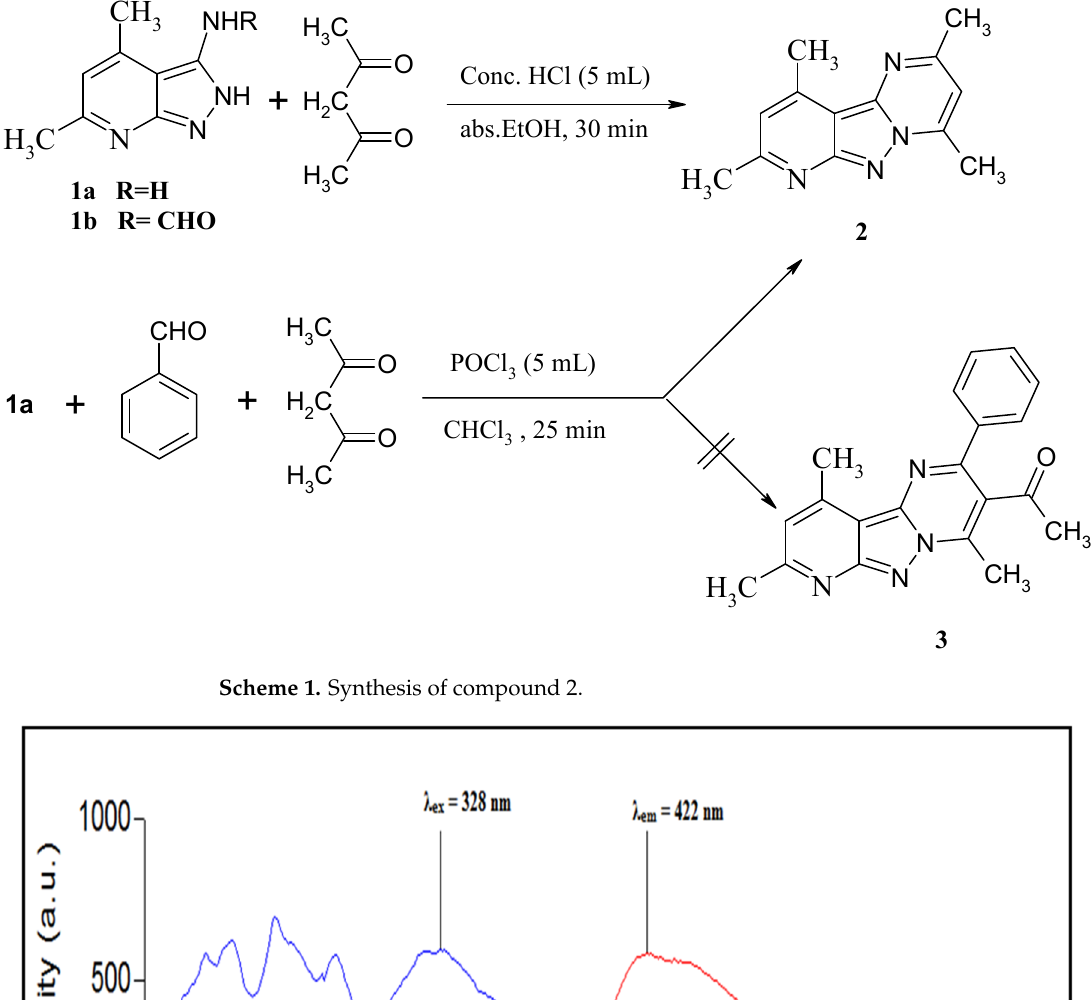
Figure 2. Excitation and emission spectra of pyridopyrazolopyrimidine 2. Various factors influencing both the fluorescence and quenching of the fluorophore were studied. The studied parameters were a type of diluting solvent, medium pH, rea- gent volume, surface-active agent type and concentration, and quantum yield.